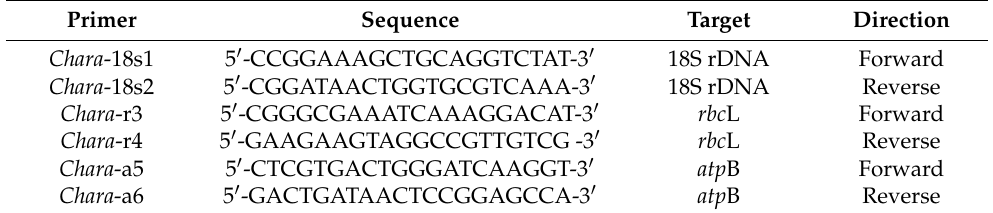
Table 2. Summary of oligonucleotide primers used for polymerase chain reaction (PCR) and sequencing. Primer